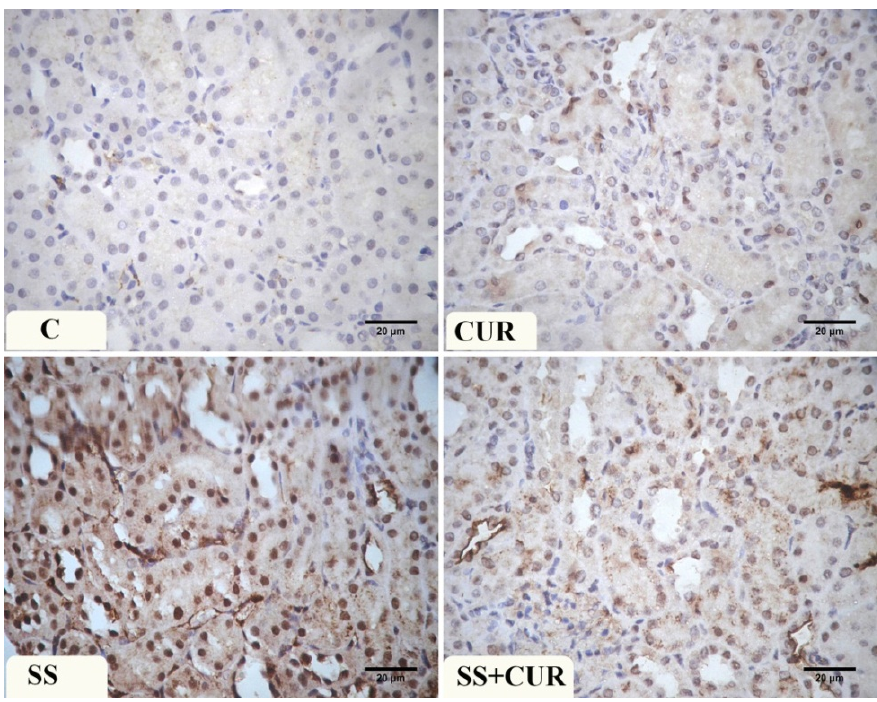
Figure 5. Photomicrograph of the renal tissue sections showing the NF-κB immuno-expression in different studied groups: (C) control, (CUR) curcumin, (SS) sodium salicylate, and SS+CUR-treated groups. Magnification ×400.